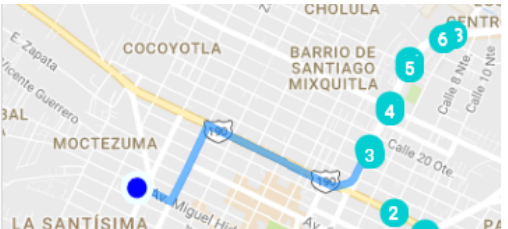
Figure 4. Stops at the